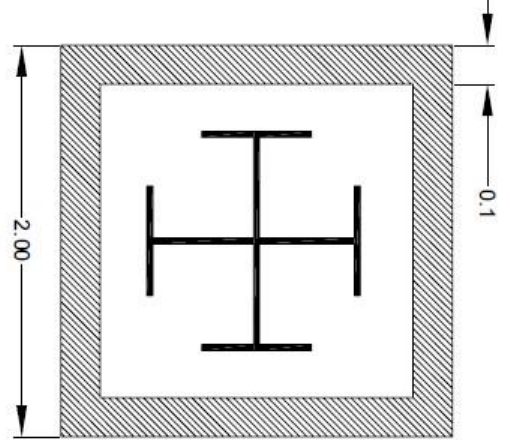
Fig. 5. Mega column type section (2 (m) – 0.1